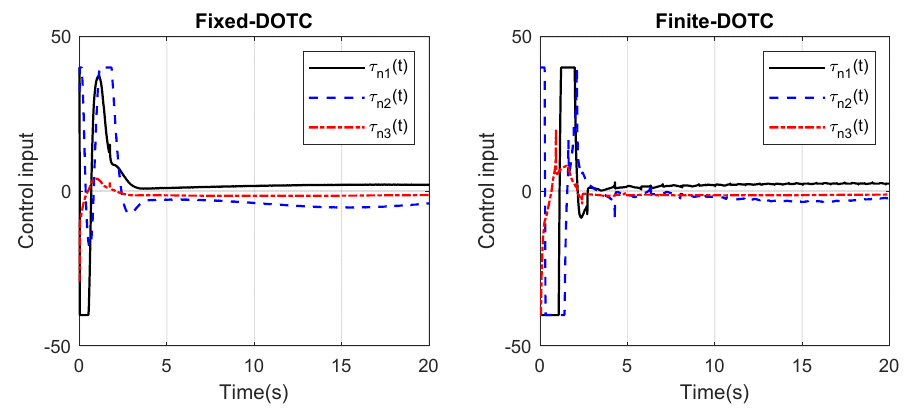
Figure 16. The control input in part 3.